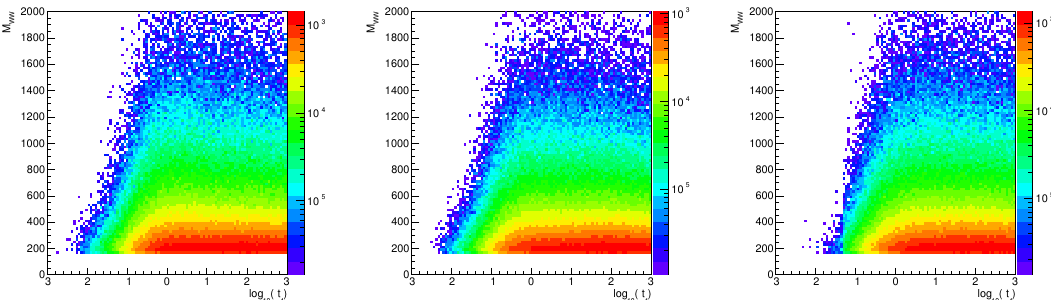
Figure 12 . Distributions in Q 2 ALLM97, SU for